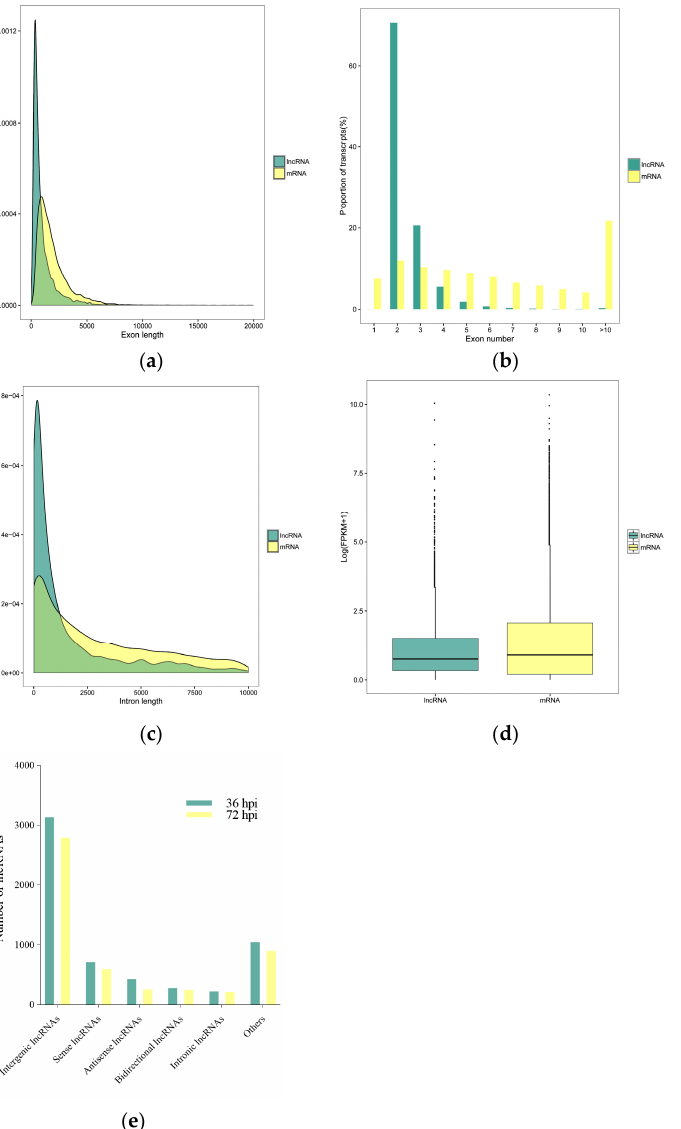
Figure 2. Characteristics of P. xylostella lncRNAs. ( a ) Exon lengths of lncRNAs and mRNAs. ( b ) Number of exons in each lncRNA and mRNA. ( c ) Size distributions of introns for lncRNAs and mRNAs. ( d ) Expression levels of lncRNAs and mRNAs. ( e ) LncRNA family